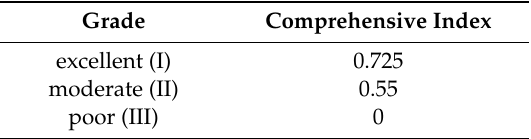
Table 4. Grading criteria of WECC and subsystems.